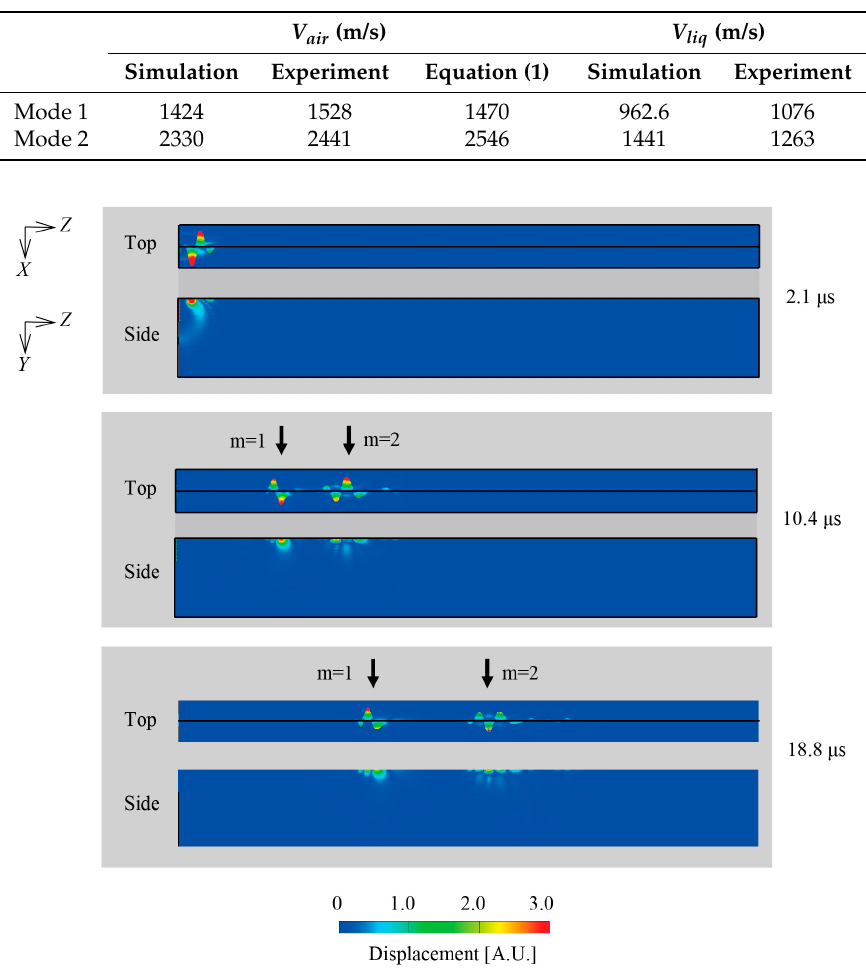
Figure 5. Simulation results of wedge wave traveling from the air to the water. Side views of the waveguide are shown from 8 to 32 μ s. The reflected mode 1 and mode 2 wedge waves propagate to the left at 24 μ s and 32 μ s.